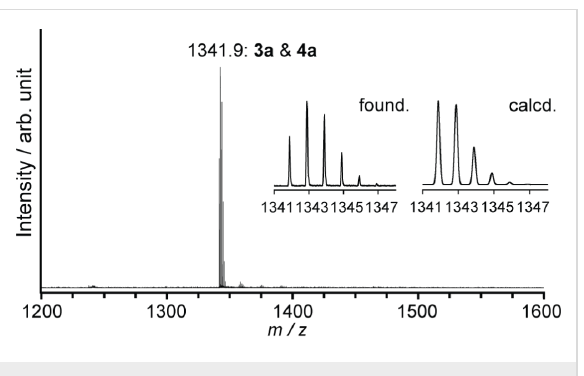
Figure 4: MALDI–TOF mass spectrum (negative mode) of the reac- tion mixture from La 2 @C 80 and 1a , using 1,1,4,4-tetraphenyl-1,3-buta- diene as matrix.